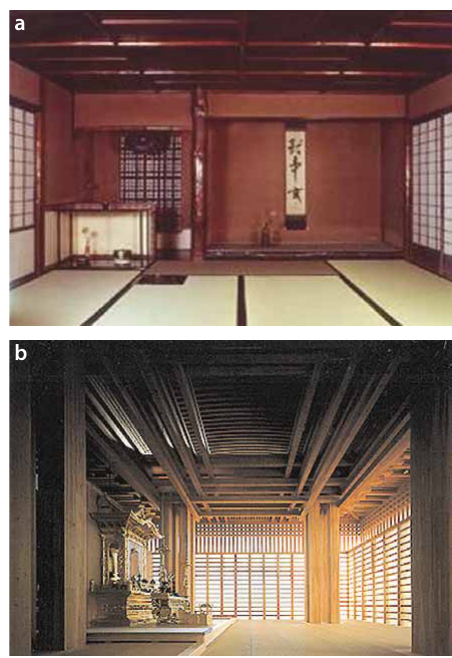
Fig. 6. Interior of Tea Drinking House (a), Totsutotsusai, Japan, ~mid-XIX; Komyo-ji (b), Interior of Komyo-ji Temple; Japan. Archit. T. Ando,